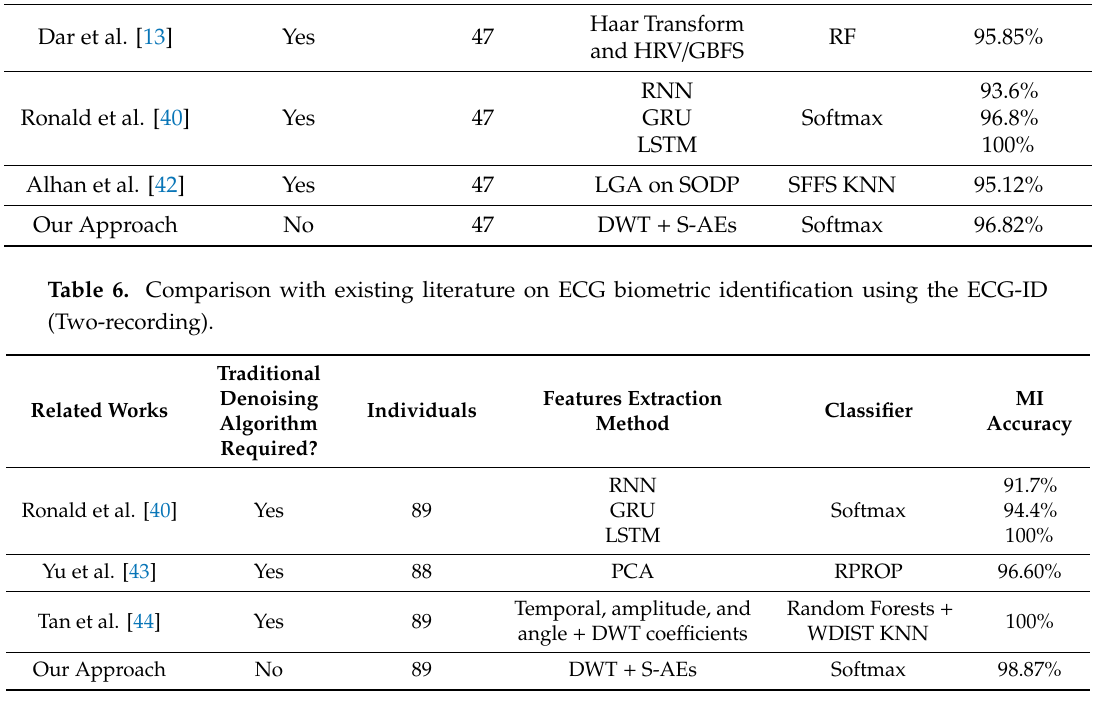
Table 7. Comparison with existing literature on ECG biometric identification using the ECG-ID